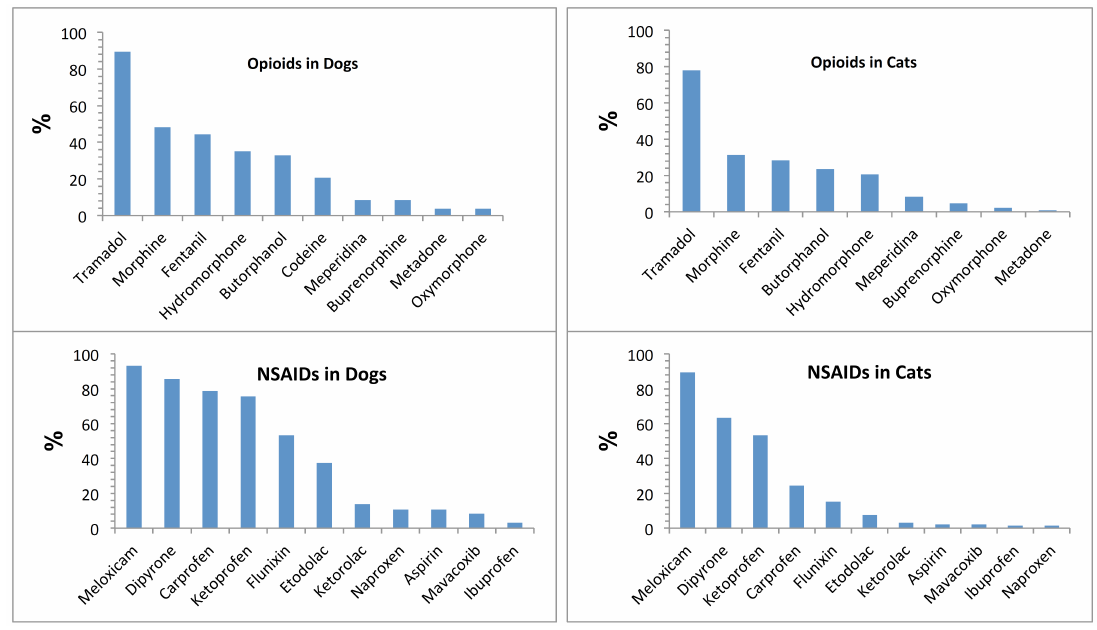
Figure 1. Double immunofluorescence staining of rat liver sections (GdCl 3 treatment) with antibodies directed against ED-1 (green) and MPO (red) followed by fluorescence immunodetection. Liver sections from different time points of study are shown: control ( A ); 3 h ( B ) and 24 h ( C ). Results shown are representative pictures of six animals and six slides per time point. (Original magnification 200×).